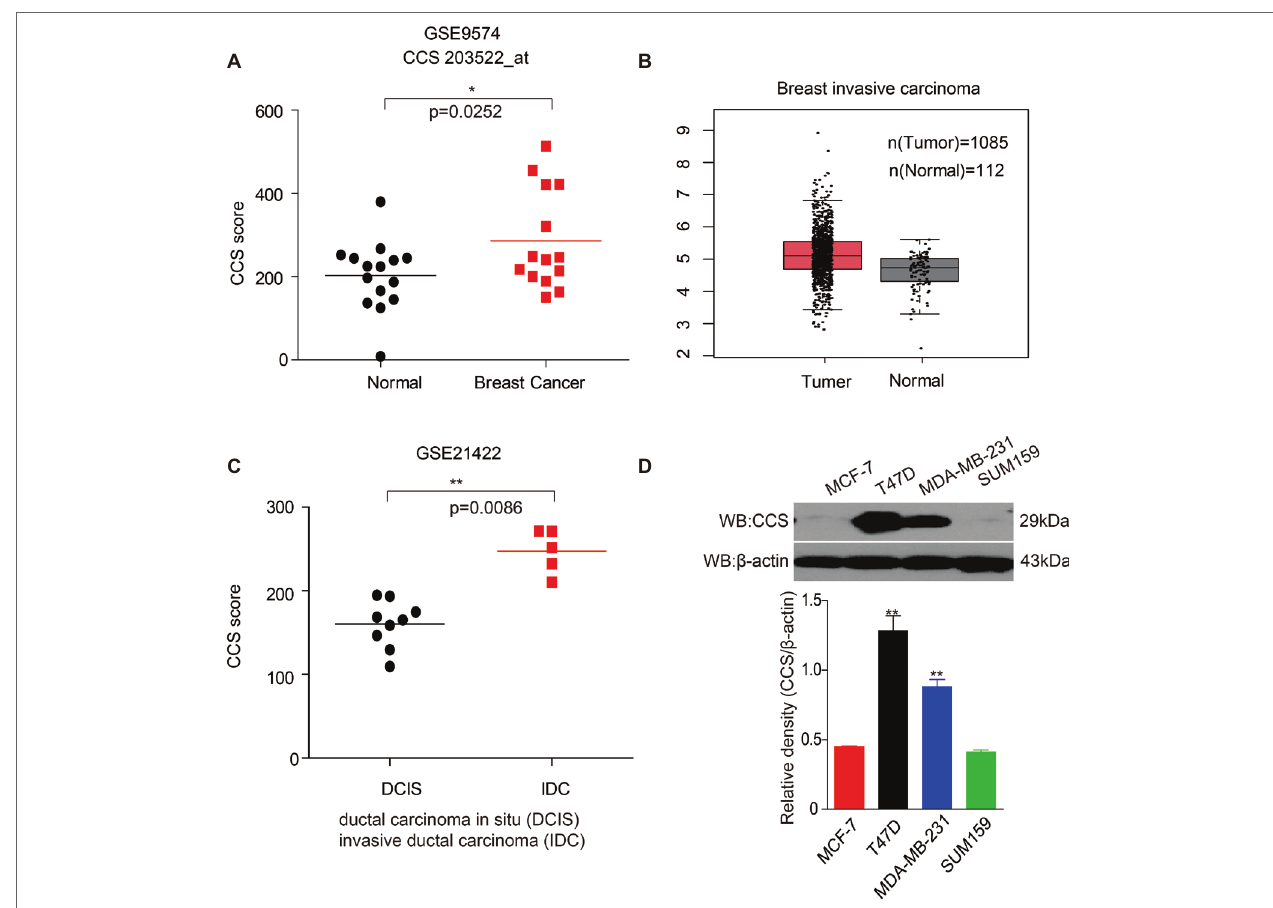
FIGURE 1 | Up-regulation of CCS is associated with cell proliferation and metastasis in human breast cancer. (A) CCS expression was analyzed in normal and breast cancer cells using Gene Expression Omnibus (GEO) profiles (GSE9574). (B) CCS expression was determined in normal and breast cancer cells in TCGA. (C) CCS expression was analyzed in ductal carcinoma in situ (DCIS) and invasion ductal carcinoma (IDC) using Gene Expression Omnibus (GEO) profiles (GSE21422). (D) CCS protein levels were analyzed in the majority of a spectrum of diverse human breast cancer cells, including MCF-7, MDA-MB-231, SUM159, and T47D by western blotting. *p < 0.05; **p <